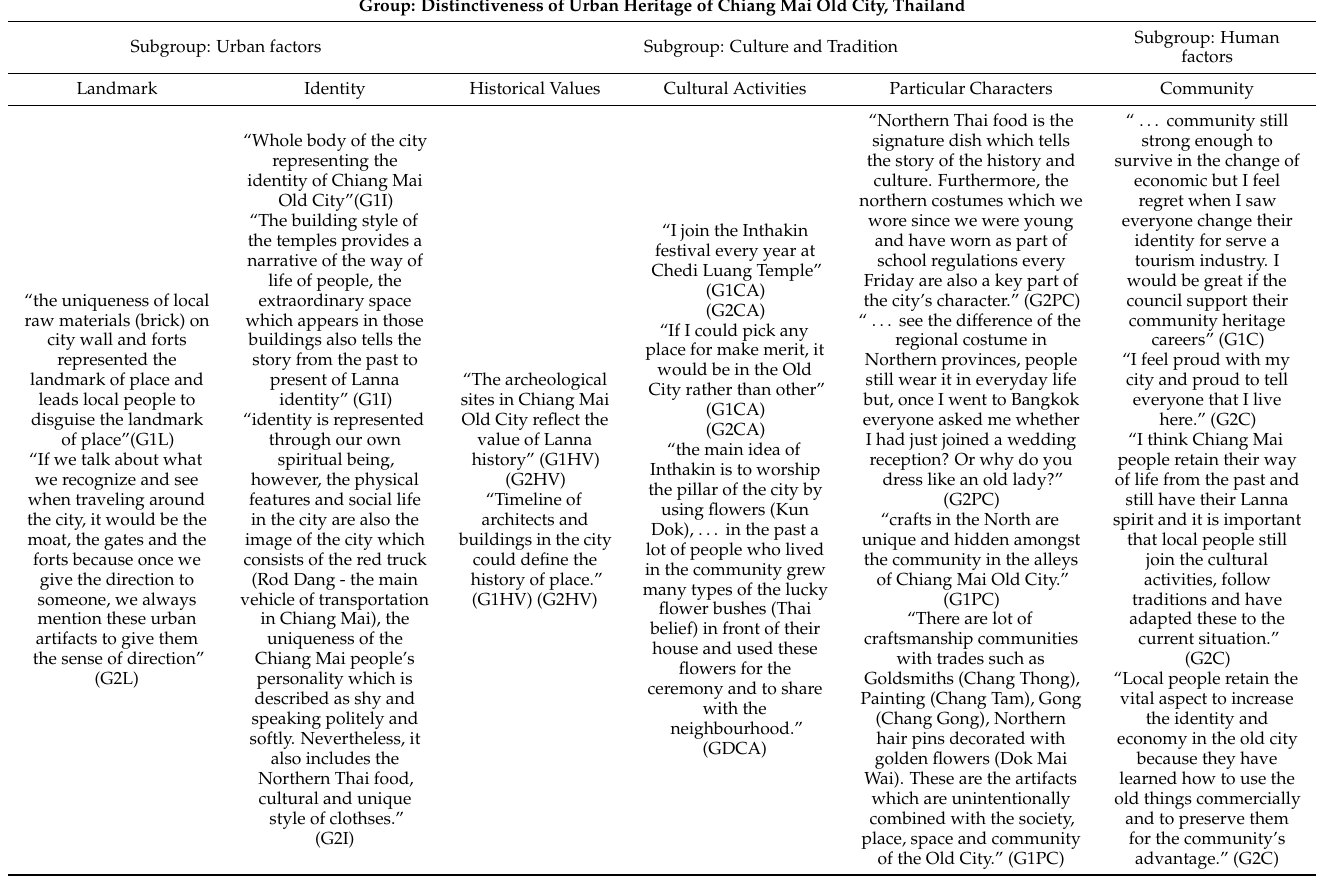
Table 6. The result of focus group